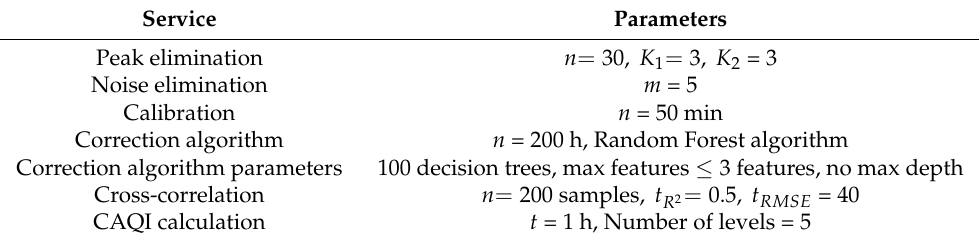
Table 2. Configuration of Node #1.1 and Node #2.1 data processing